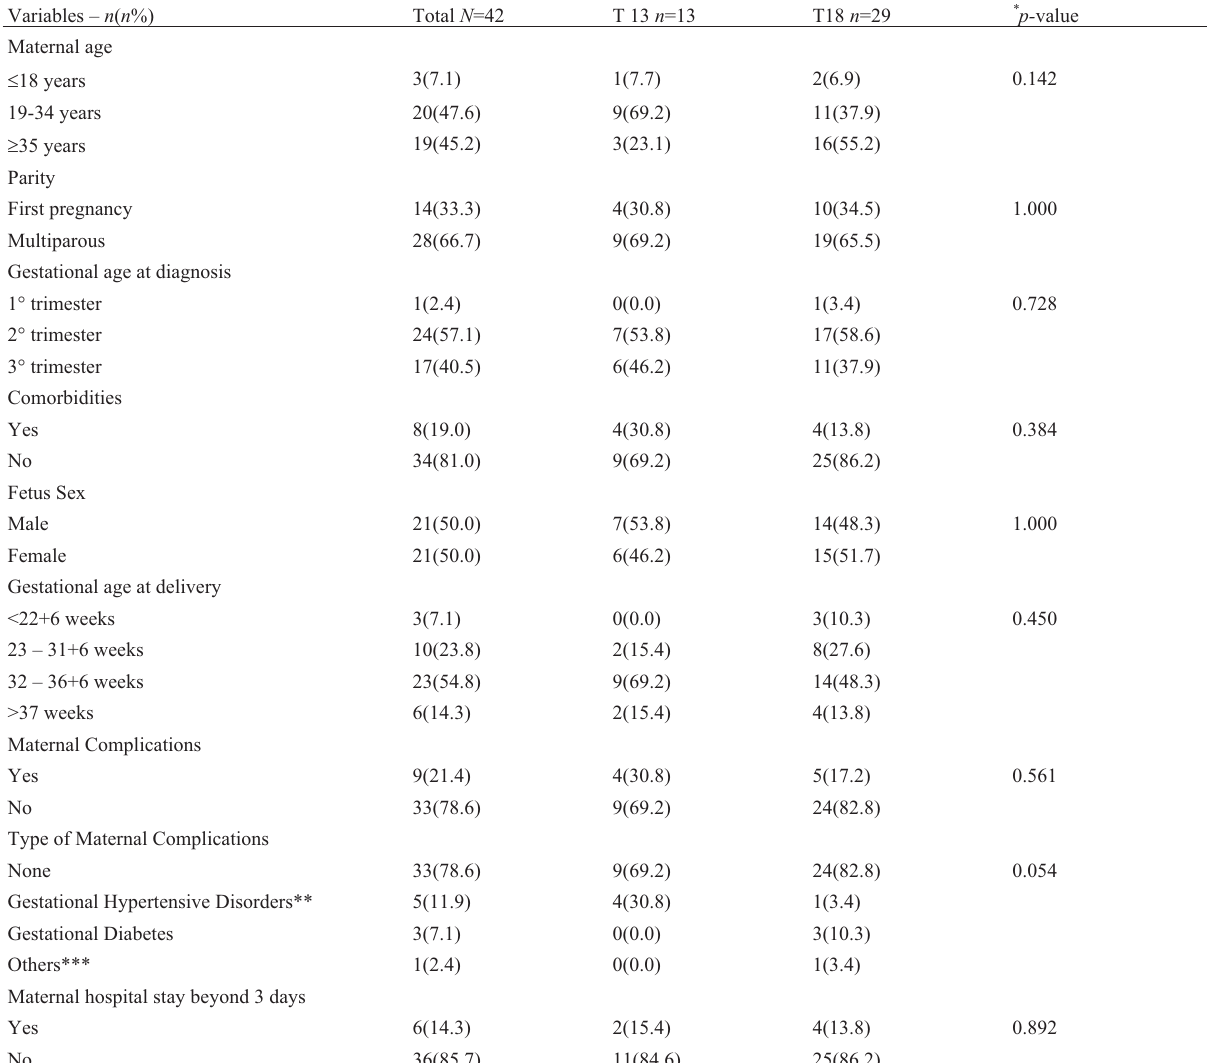
Table 1 - Sample characterization of trisomy 13 and 18 pregnancies. Variables – n ( n